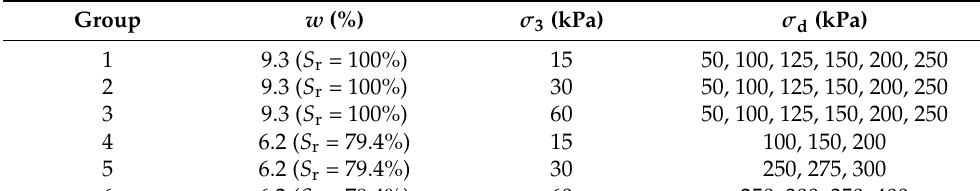
Table 1. Detailed program of cyclic triaxial tests.